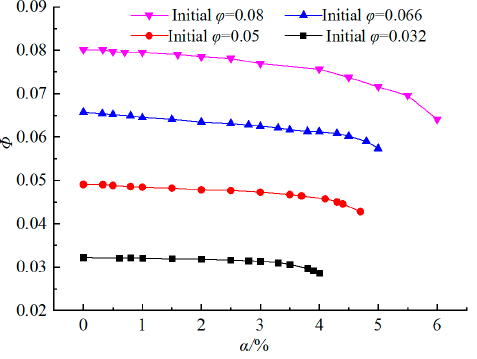
Figure 5. Pump theoretical head coefficients for two rotational speed: ( a ) n = 1450 r/min and ( b ) n= 1000 r/min.